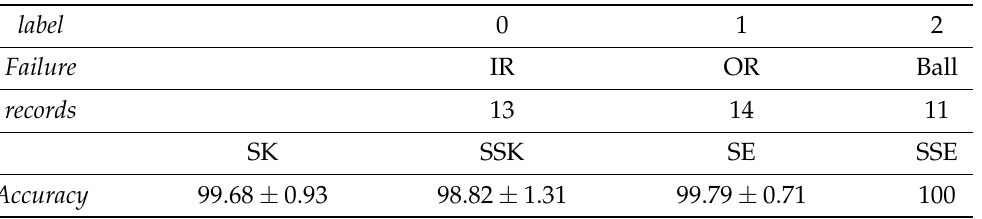
Table 8. Results of classifier performance. Upper part, Universidad Nacional de Colombia (UNC) dataset used for classifier training, holding assigned class labels, failure types and number of faulty records. Lower part, classification accuracy of each filtering approach.